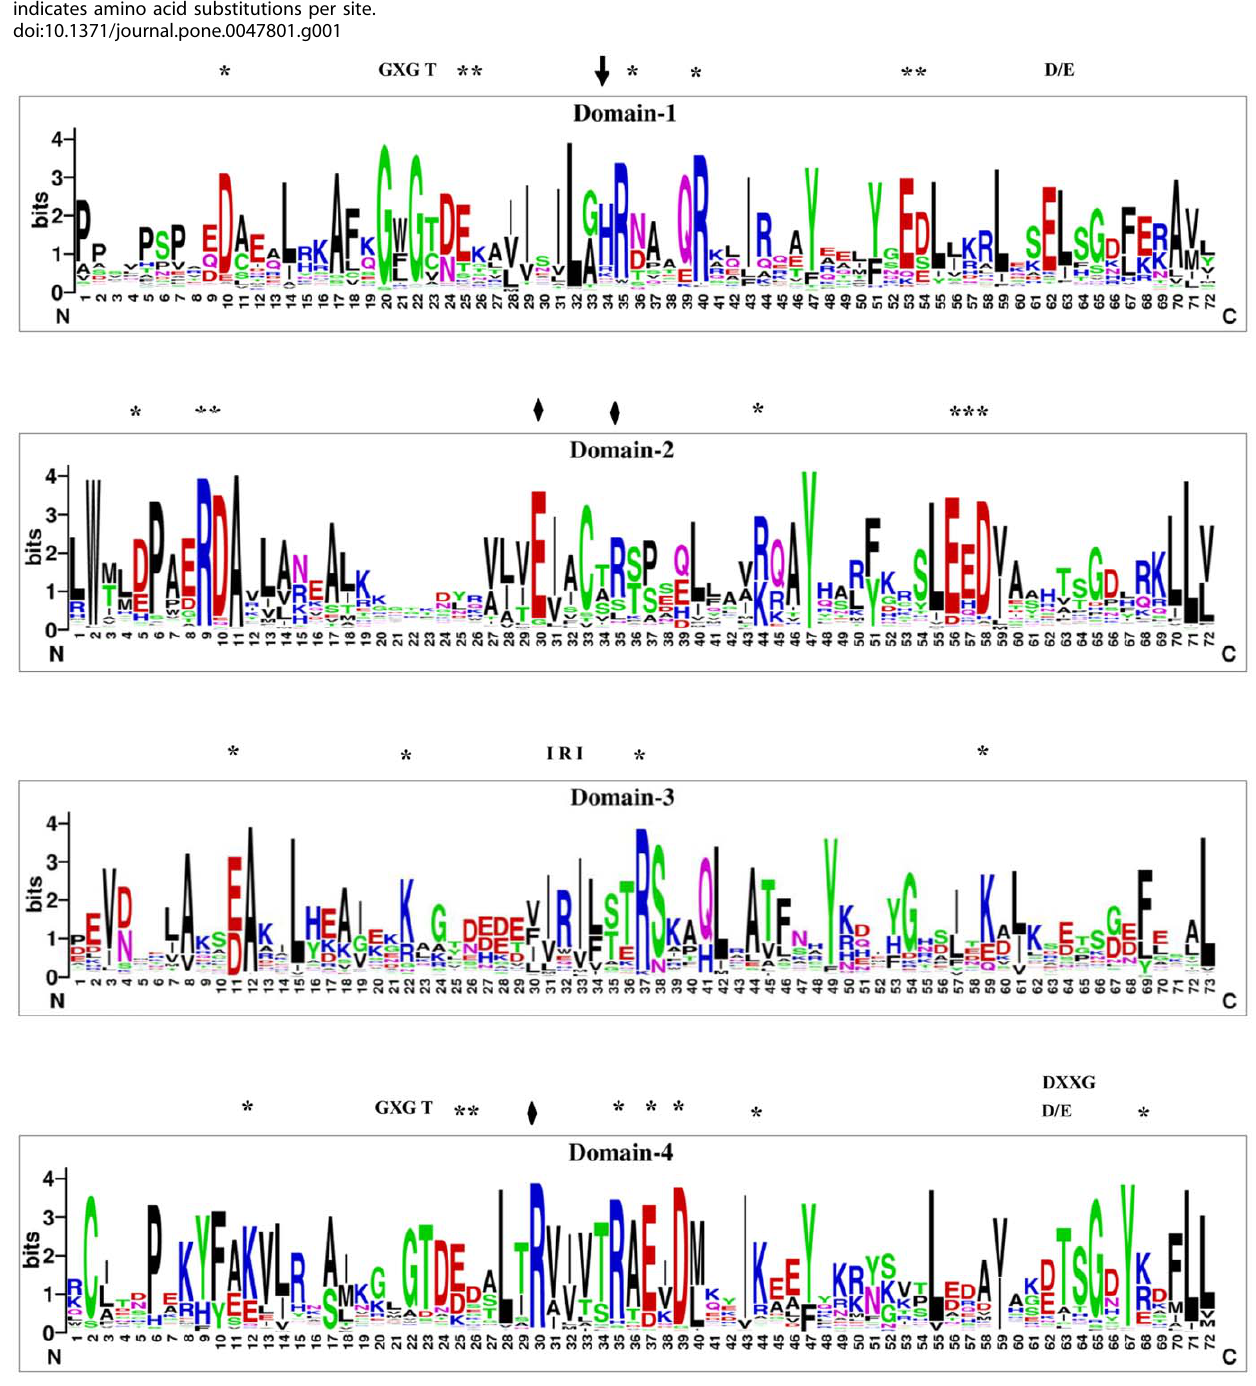
Figure 2. Sequence logos of four annexin domains. The sequence logos were generated by amino acid alignment of individual domains from 149 annexins using WebLogo. The taxon-specific indels were removed to optimize the alignments. The height of letter designating the amino acid residue at each position represents the degree of conservation. The GXGT and D/E, IRI and DXXG motifs are represented on the top of each plot. The conserved His residue in the heme motif is indicated by an arrow. The residues thought to be involved in ion channel activity are represented as diamonds. Asterisks (*) indicated the conserved residues observed in the alignment of 149 annexins. The numbers on the x-axis represent the sequence positions in annexin domains. The y-axis represents the information content measured in bits.